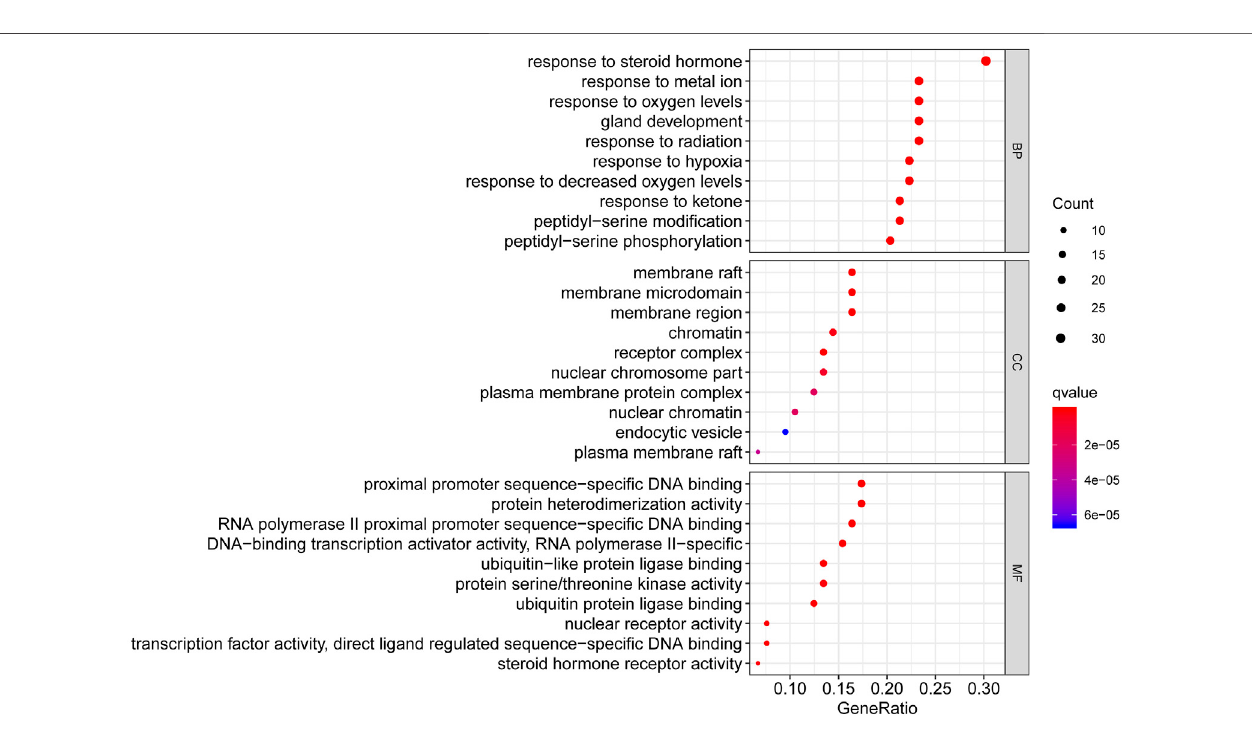
Frontiers in Pharmacology |